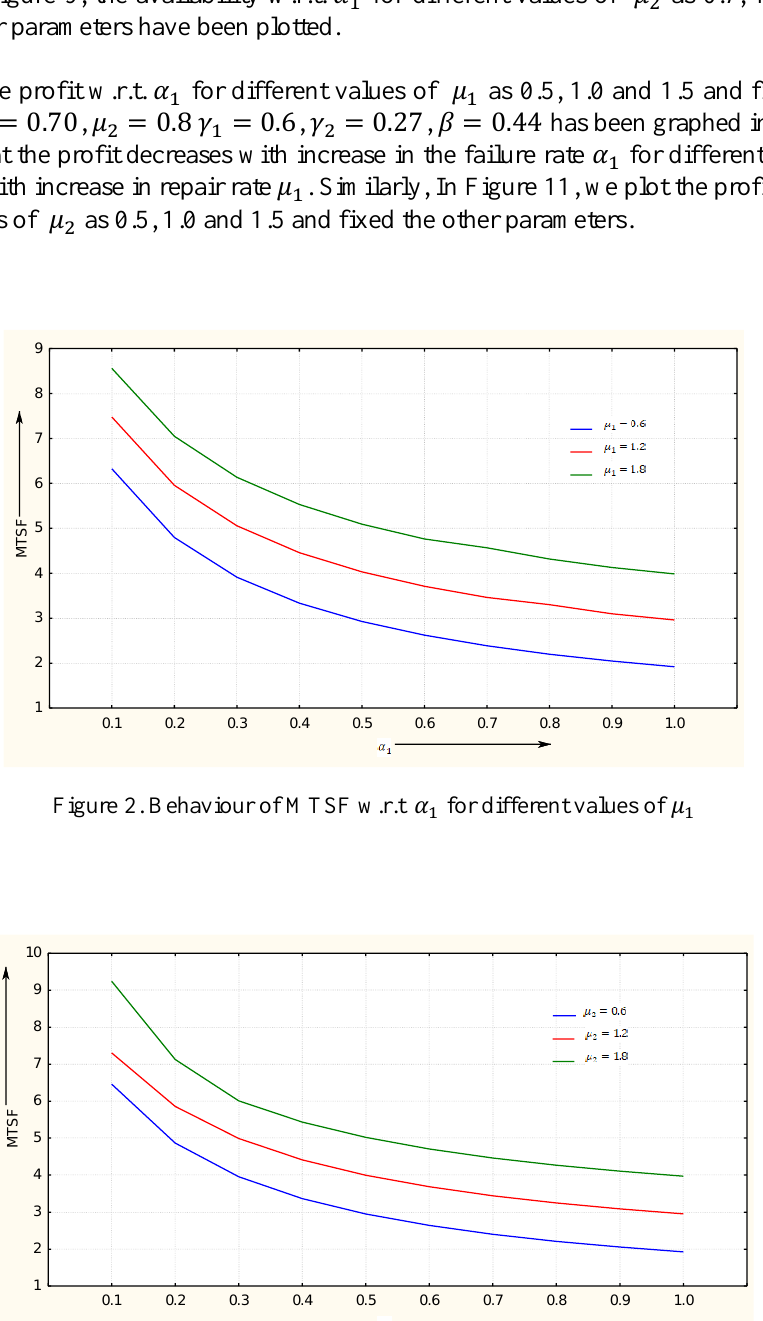
for different values of 𝜇 1